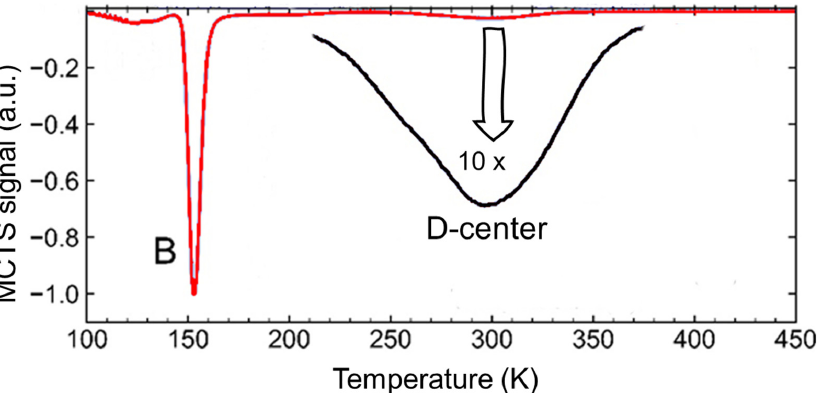
Figure 7. A normalized MCTS spectrum for the n-type 4H-SiC SBD. Data adapted from Ref. [32].